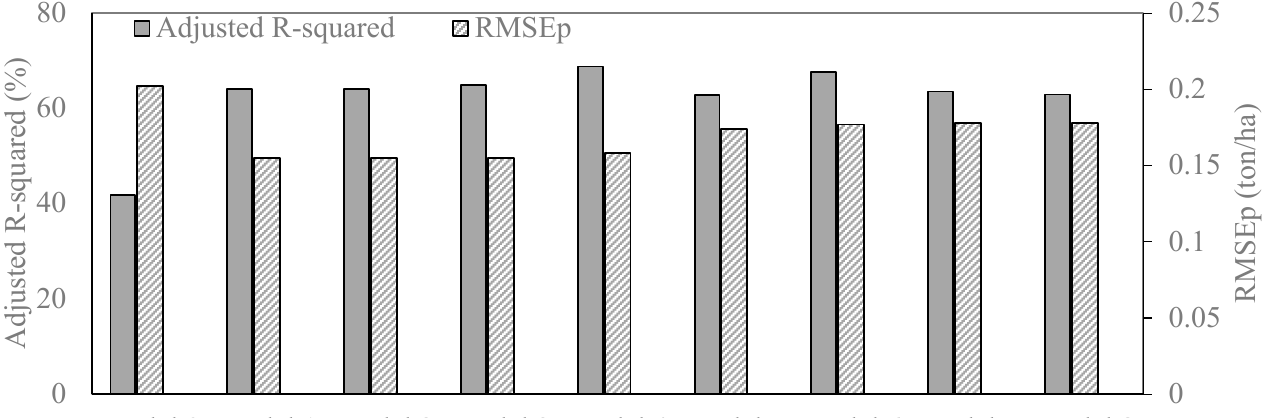
tion, RMSEp = root mean square error for prediction, RRMSE = relative root mean square error (%).